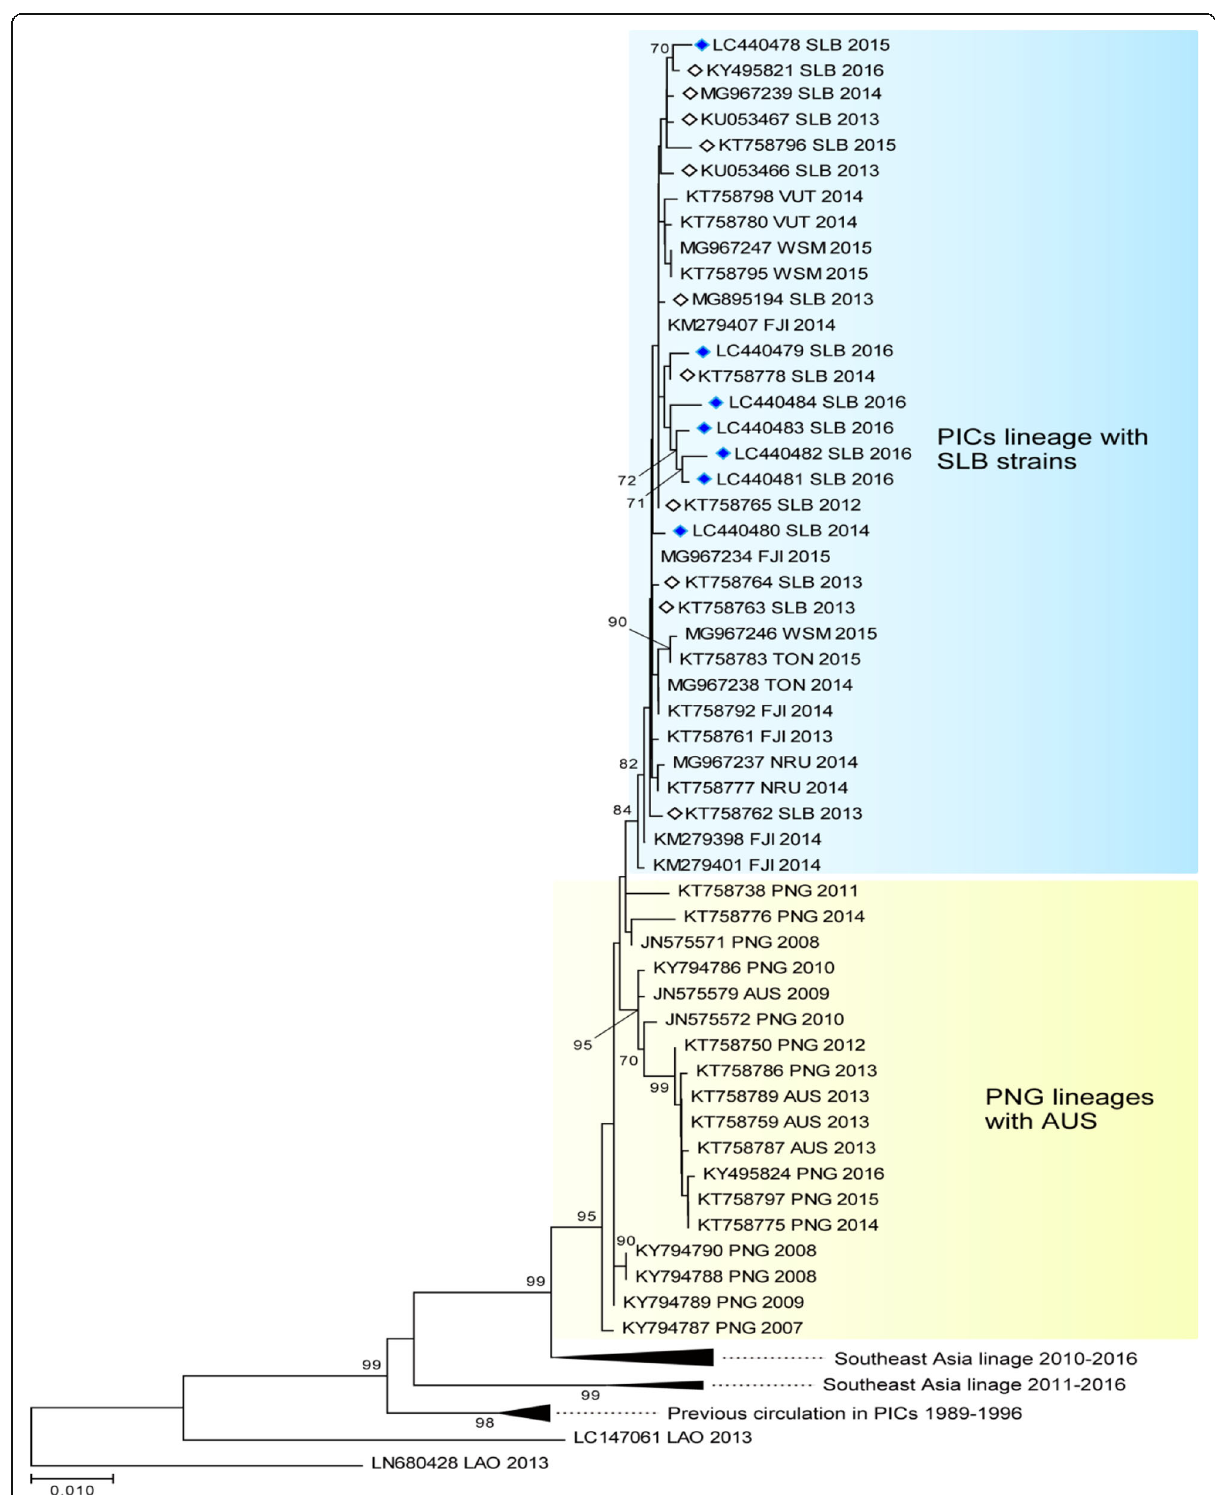
Fig. 4 The evolutionary history of the DENV according to an analysis of DENV-3 envelope gene (1479-bp) sequences performed using the maximum likelihood method. The numbers for each node indicate bootstrap values ( ≥